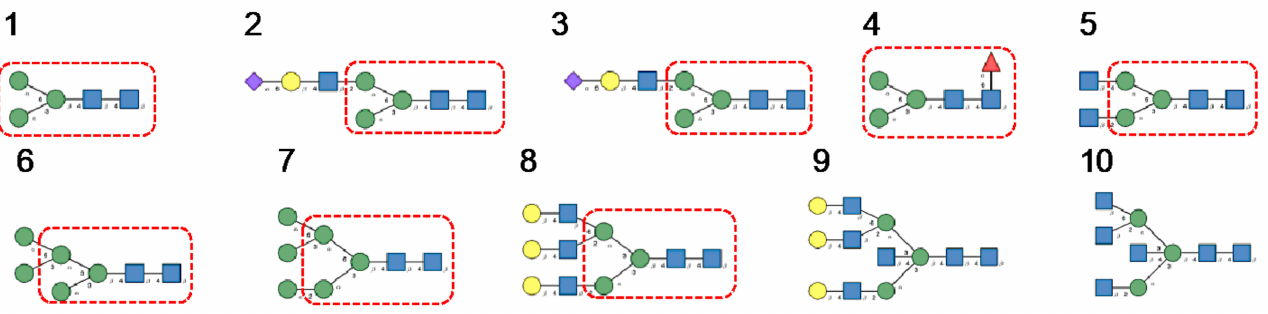
Figure 10. Glycans recognized by Morniga-M in glycan array experiments, arranged from 1 to 10 in decreasing order of